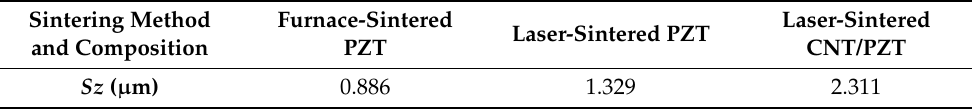
Table 7. Average peak-to-valley measurement comparison of sintered